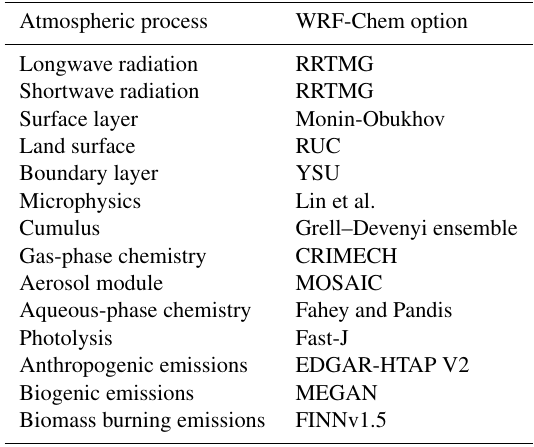
Table A1. WRF-Chem